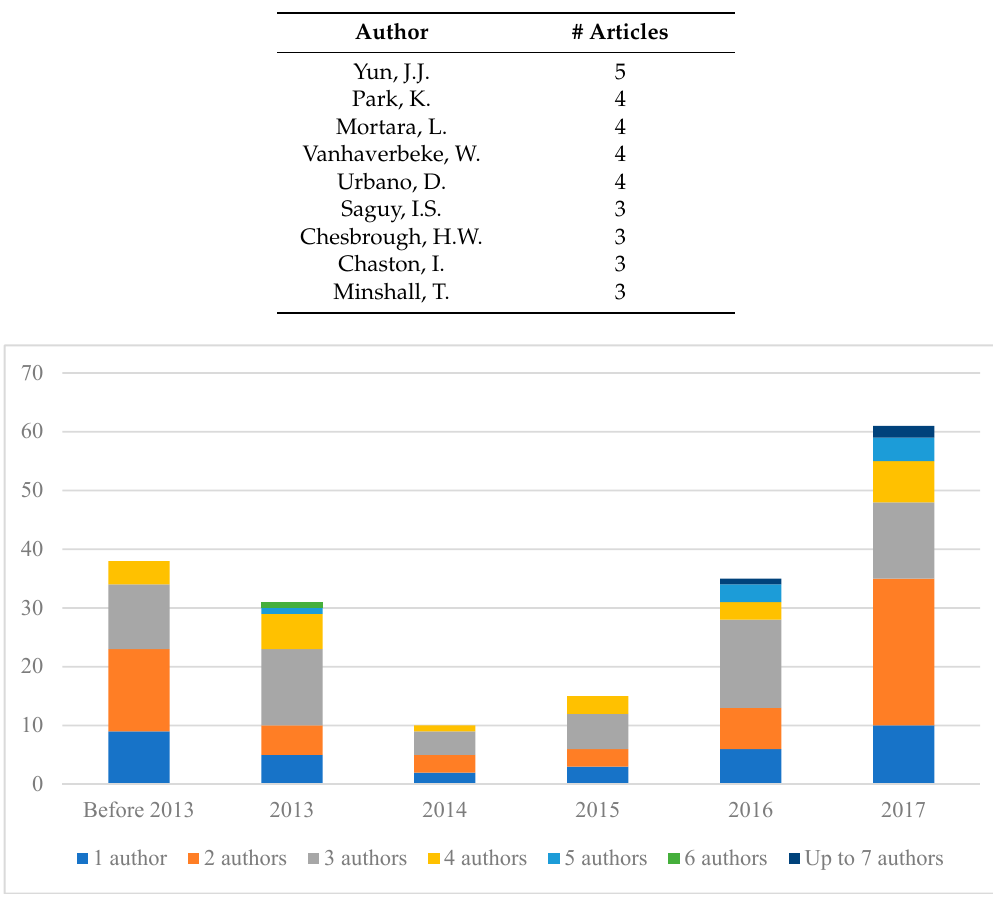
Table 4. Authors with the most co-authors.